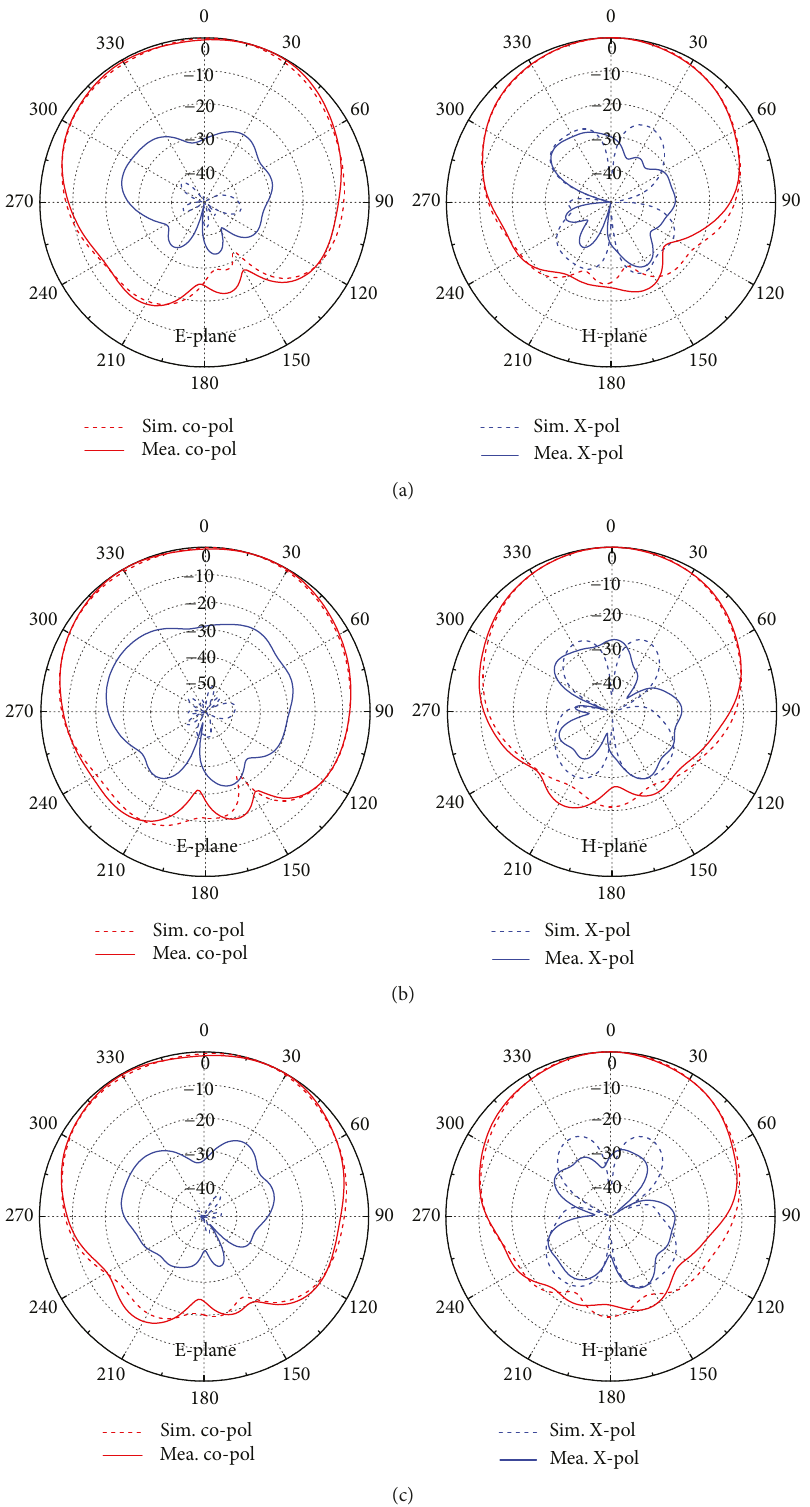
Figure 12: Simulated and measured radiation patterns at three resonance poles. (a) 4.12GHz. (b) 4.26GHz. (c)